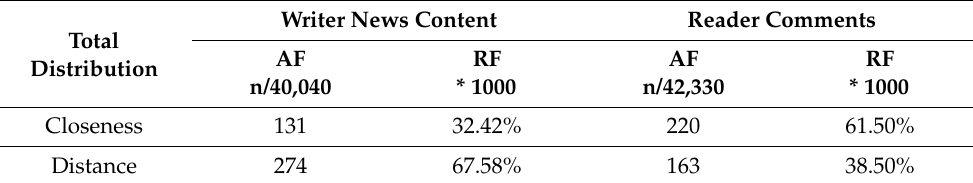
Table 1. Total distribution of closeness and distance pragmatic strategies in the two corpora.